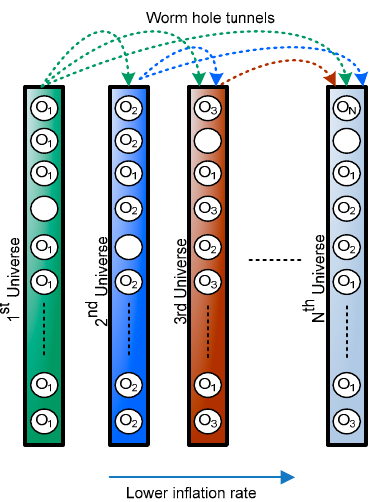
Figure 3. Basic idea of a multi-verse optimization (MVO) algorithm.